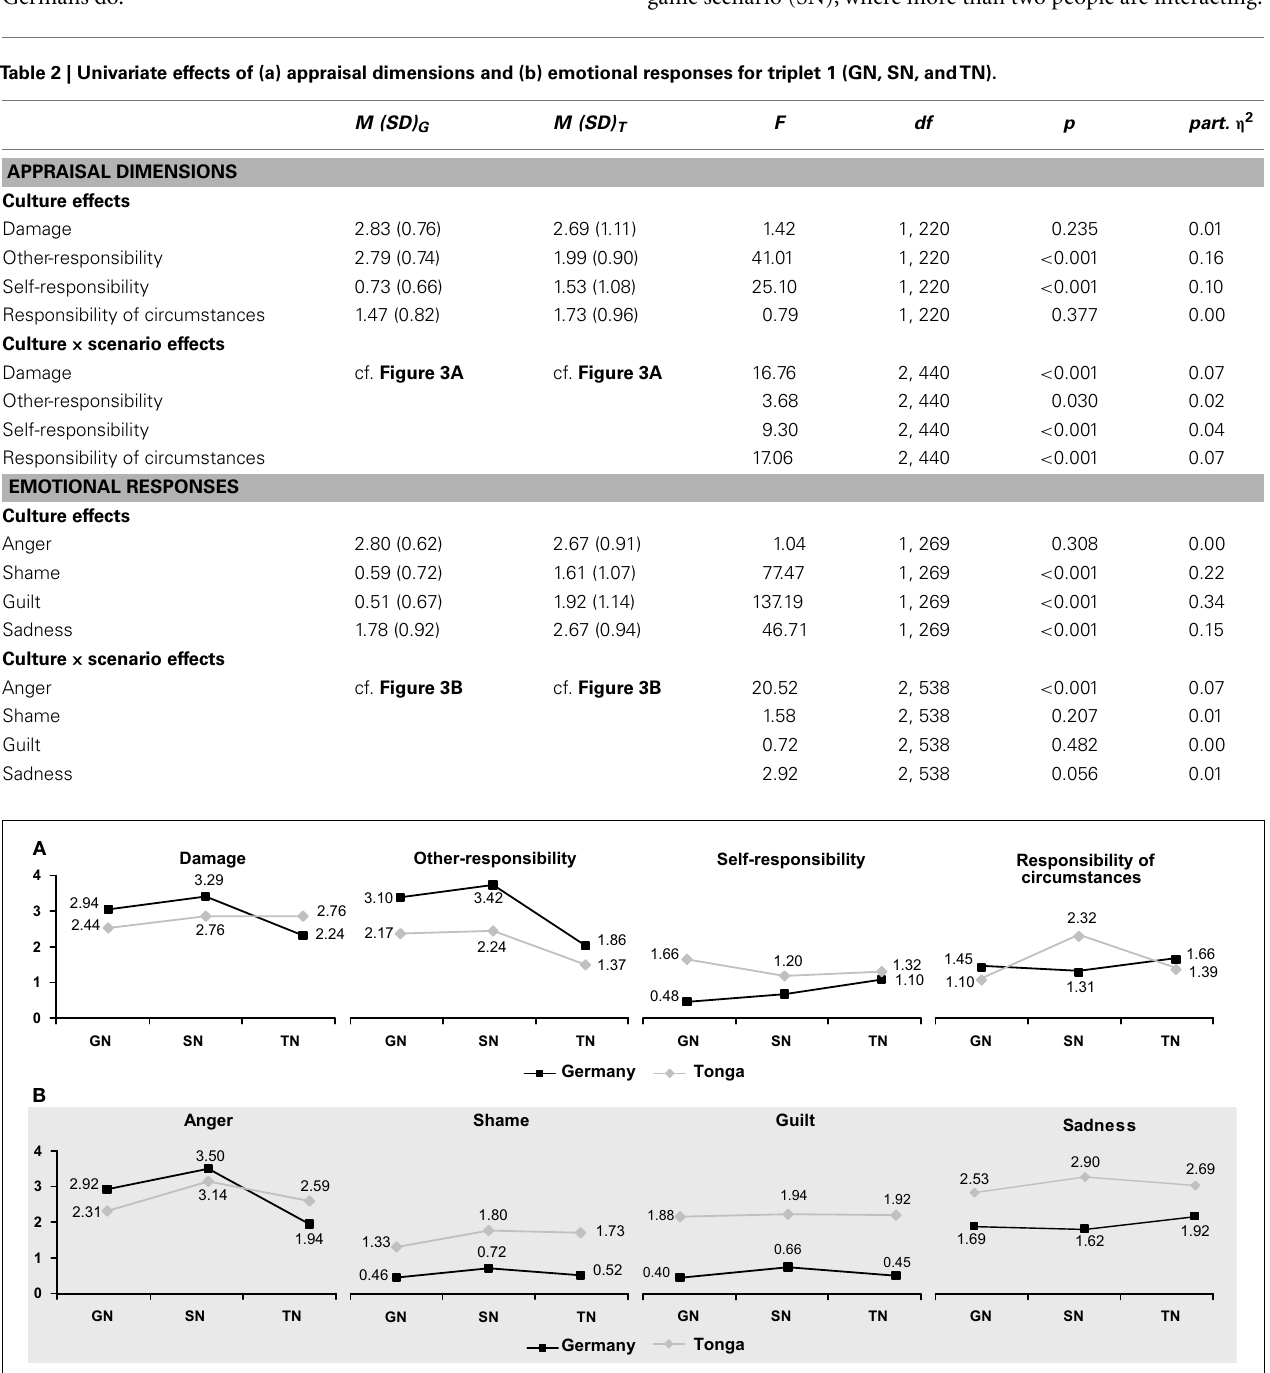
FIGURE 3 | Intensity ratings of (A) appraisal dimensions and (B) emotional responses for triplet 1 as a function of culture and scenario.